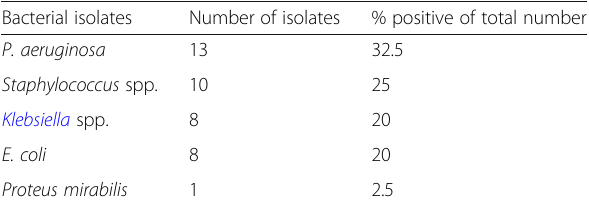
Table 1 Distribution of the bacterial isolates from wound